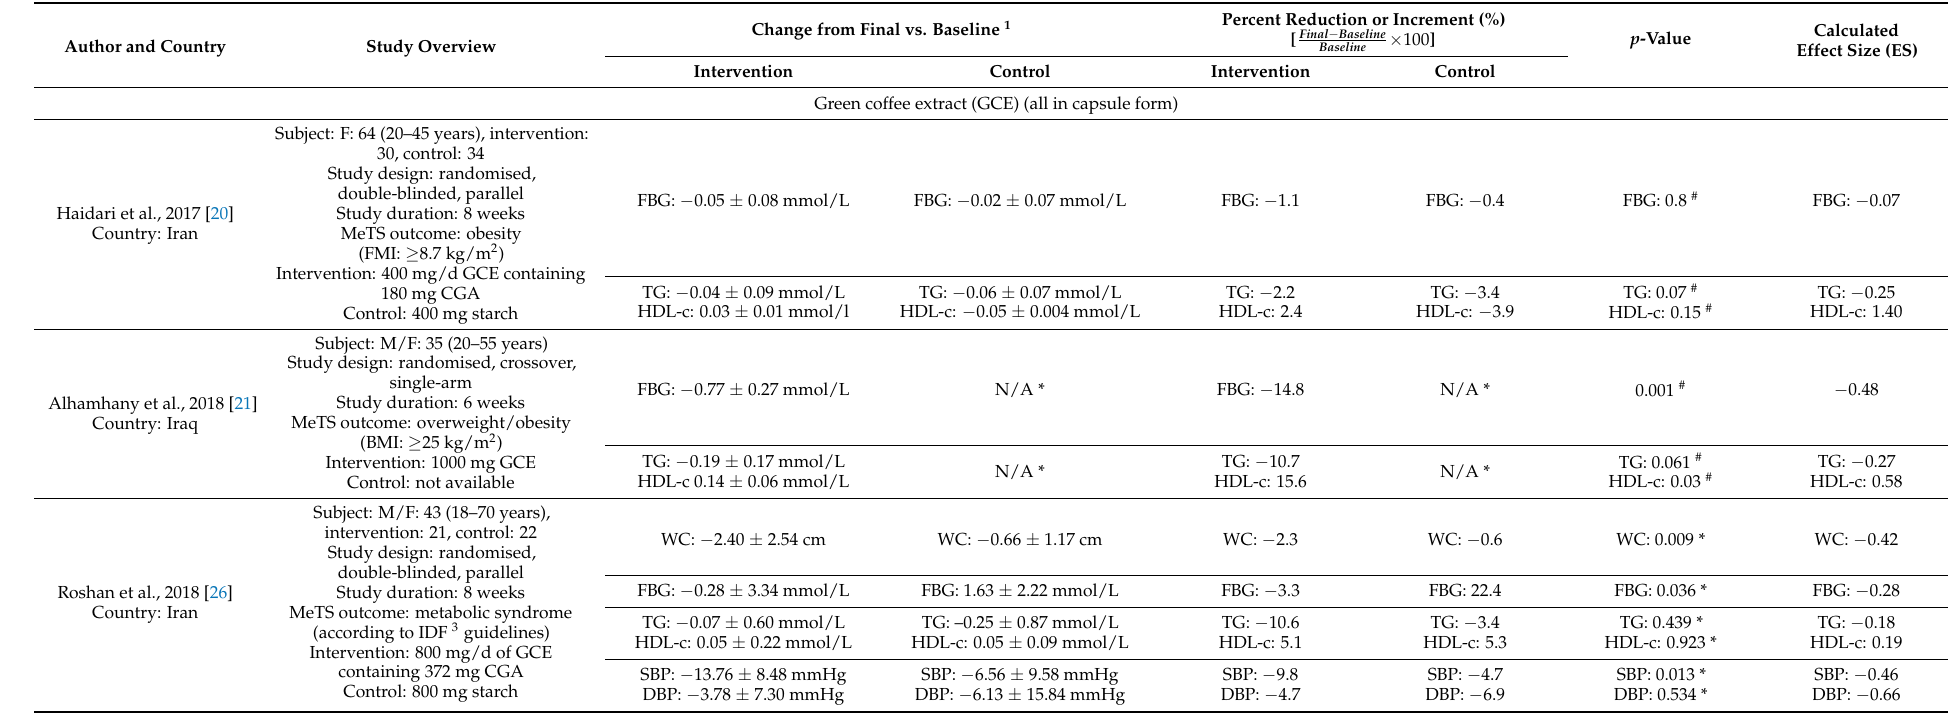
Table 1. Summary of randomised controlled controlled trials (RCTs) included in systematic review ( n =